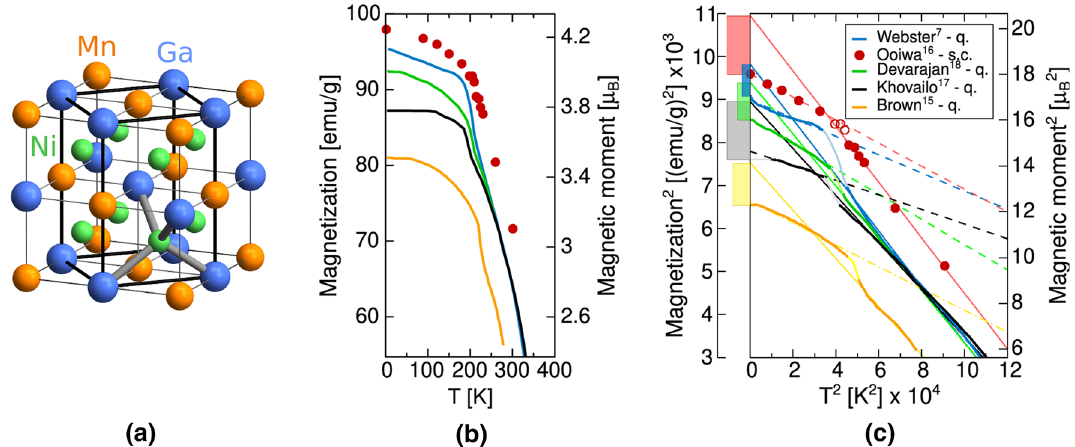
Figure 2. ( a ) Relaxed austenite lattice constant as a function of U applied to different sites compared with HSE03 and experimental value 6 , ( b ) bulk modulus calculated using HSE03 and DFT + U (colour lines) compared with experiments (black line 51 and grey area 13,51,52 ), and ( c ) total magnetic moments calculated using HSE03 and DFT + U compared with experimental value measured on modulated martensite 6 . Solid lines represent cubic austenite (in ( c ) panel the black solid line belongs to extrapolated value) and dash-dotted/ dashed lines belong to NM/10 M martensite. Both HSE03 and U on Ni predict larger total magnetic moment of austenite comparing to NM martensite at 0